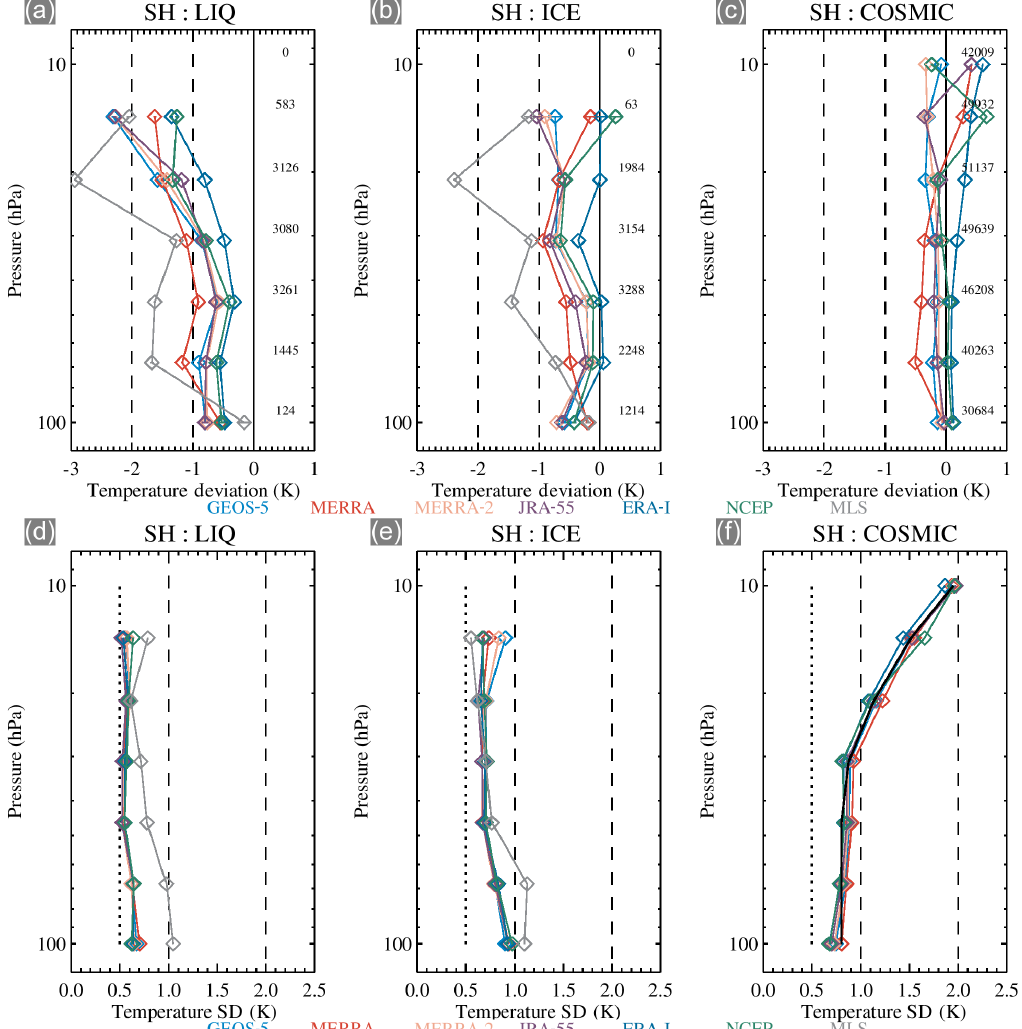
Figure 16. Vertical profiles of median temperature deviations from T eq for (a) LIQ PSCs and (b) ICE PSCs for the temperature distributions accumulated over the Antarctic PSC seasons (20 May (d140) to 18 August (d230) from 2008 to 2013). Lines for the different reanalyses, GEOS-5.9.1, and MLS are color coded (see legend); the numerical values on the right-hand side of each panel indicate the total number of observations in the distribution at the corresponding pressure level. (c) The same as for panels (a, b) except for deviations with respect to COSMIC GPS RO. (d, e, f) The standard deviations of the corresponding temperature distributions shown in panels (a, b, c) . Dotted lines indicate a standard deviation of